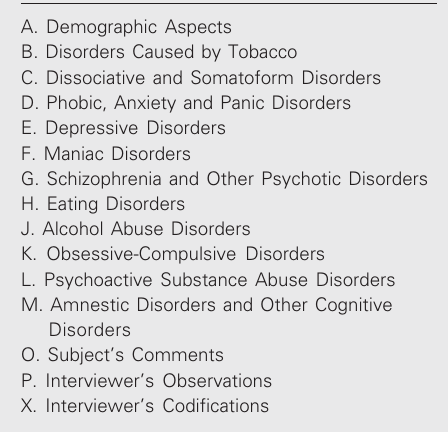
Table 1. Diagnostic and non-diagnostic sections of the Brazilian version of the CIDI